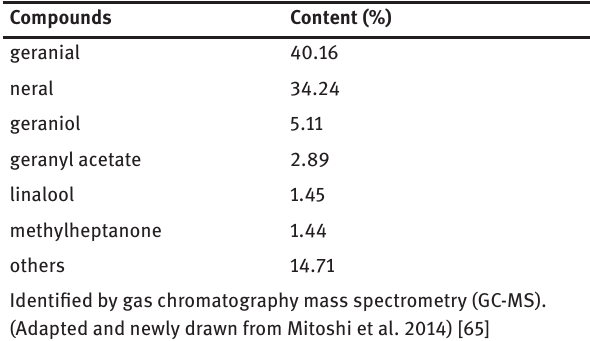
Table 4 : Chemical composition of Cympogon citratus EO.